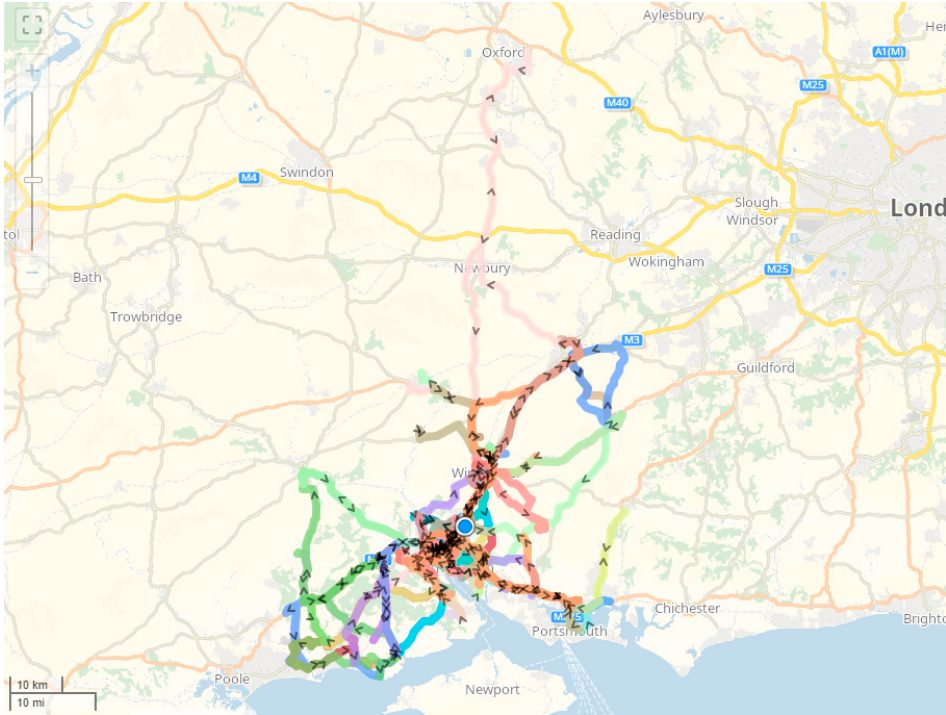
Figure 8. Map showing movements of all PTS vehicles during an example day (4 March 2021) in the intervention scenario. Blue circle shows the location of Eastleigh PTS depot. Lines with direction arrows show vehicle routes, with each different coloured line representing the route of each different vehicle on the example day.